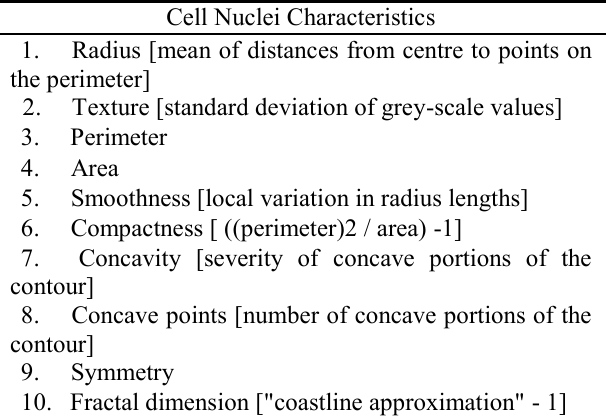
Table 1. Cell Nuclei